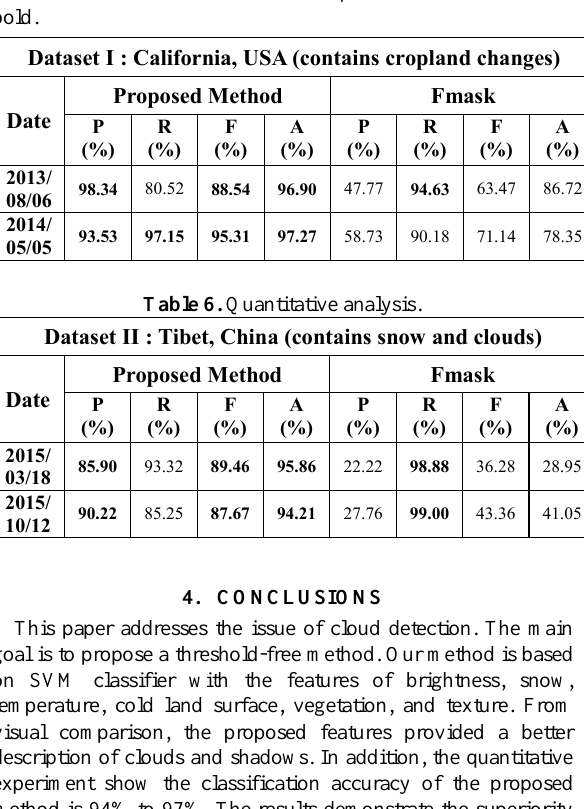
Table 5. Quantitative analysis. Precision (P), recall (R), F- bold.